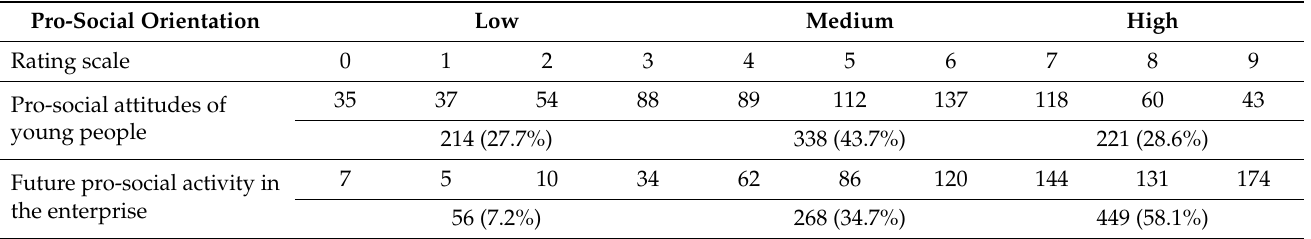
Table 3. Pro-social orientation of the younger generation—the current state and preferences regarding future pro-social activities in enterprises.